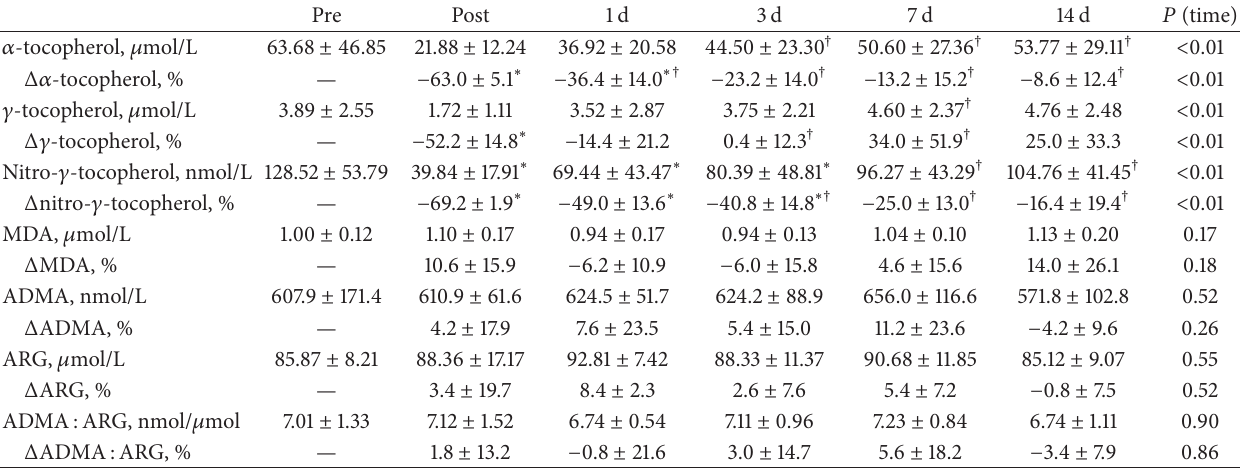
Table 3: Plasma antioxidants, markers of oxidative/nitrative stress, and nitric oxide status in patients prior to (Pre) and following LDL apheresis treatment.